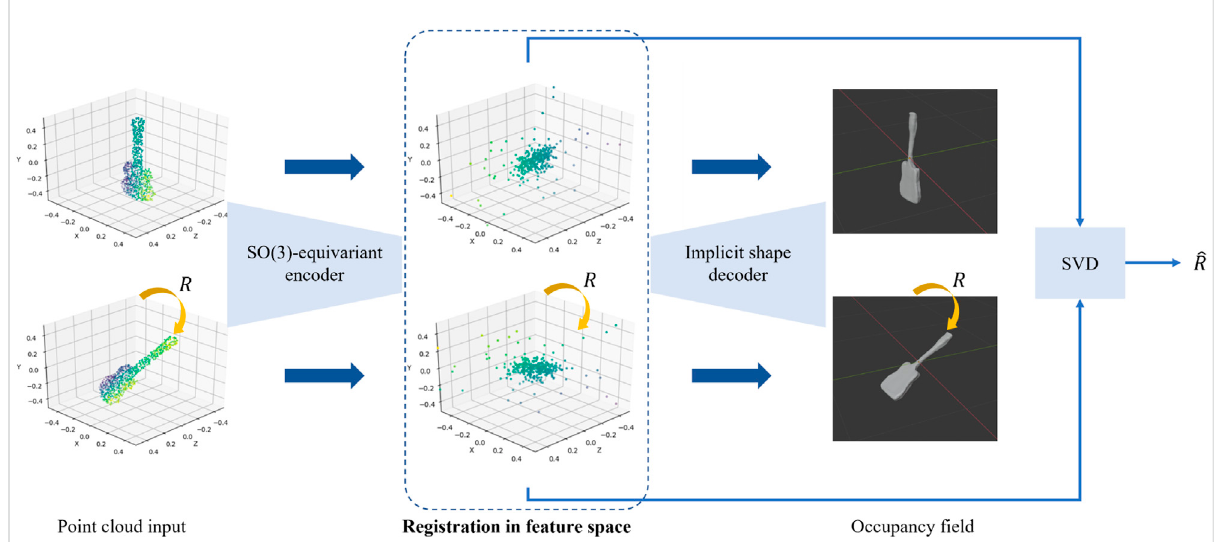
FIGURE 13 OverviewoftheSO(3)-equivariantregistration network (Zhuetal.,2022b).Thepoint cloudinputisofshape R N ×3 ,andtheencodedfeatureisof shape R C ×3 . N is the number of points, and C is the dimension of features. Occupancy fi eld is a function v ( p ) ↦ [ 0 , 1 ] , p ∈ R 3 mapping any 3D coordinate to an occupancy value. The rotation is estimated by aligning the features using Horn ’ s method (Horn et al.,